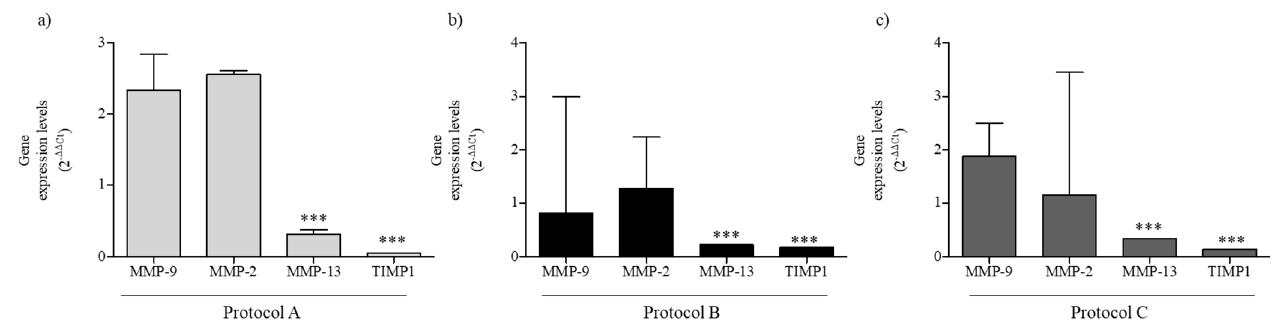
Figure 6. MMPs gene expression. MMP-9, MMP-2, MMP-13, and TIMP1 gene expression in HaCaT cells after different RF-EMF-exposure conditions. ( a ) Protocol A exposure; ( b ) Protocol B exposure; and ( c ) Protocol C exposure. The mean values of gene expression levels (2 −ΔΔ Ct ) and 95% CI of three independent experiments, were reported. *** p < 0.001 with respect to sham-exposed cells.